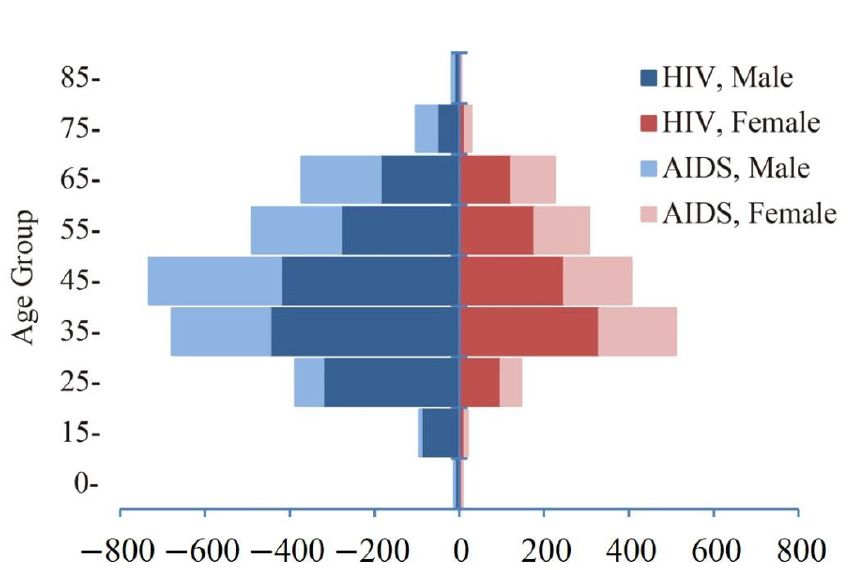
Figure 2. Age-sex pyramid of HIV/AIDS outpatients of Guangxi Province.